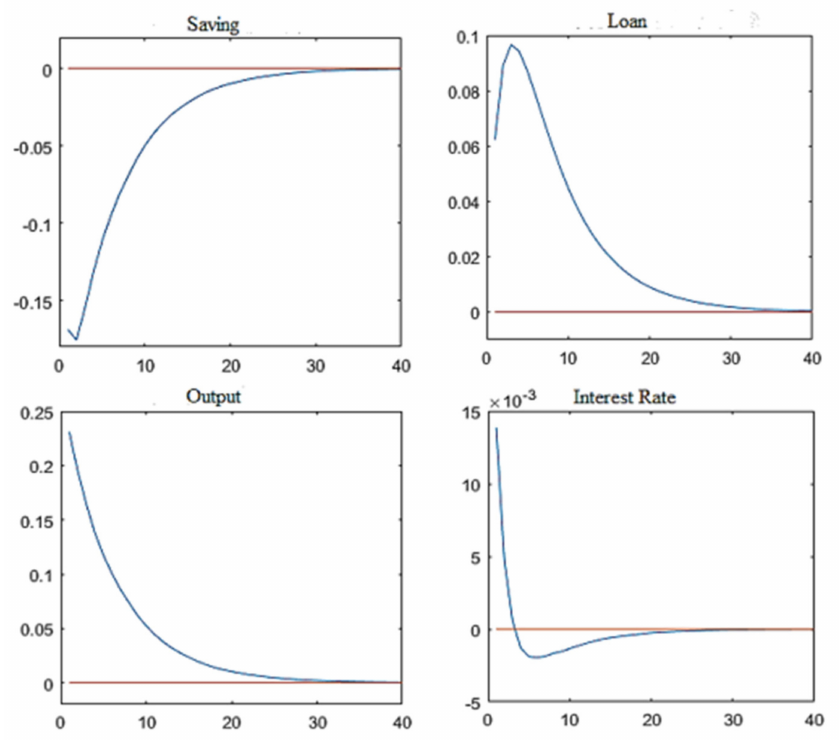
Figure 2. Impulse response results of main variables under the price monetary policy (basic model; electronic money promotes